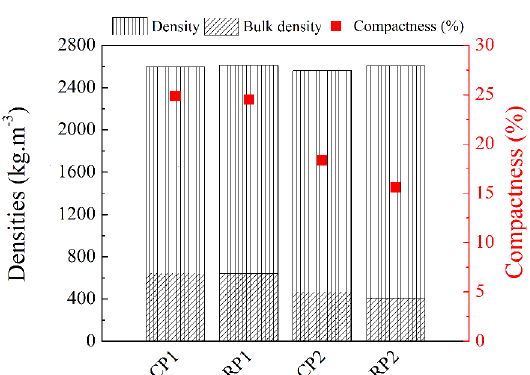
Figure 3. Bulk density (diagonal stripes), density (vertical stripes), and compactness (red squares) of